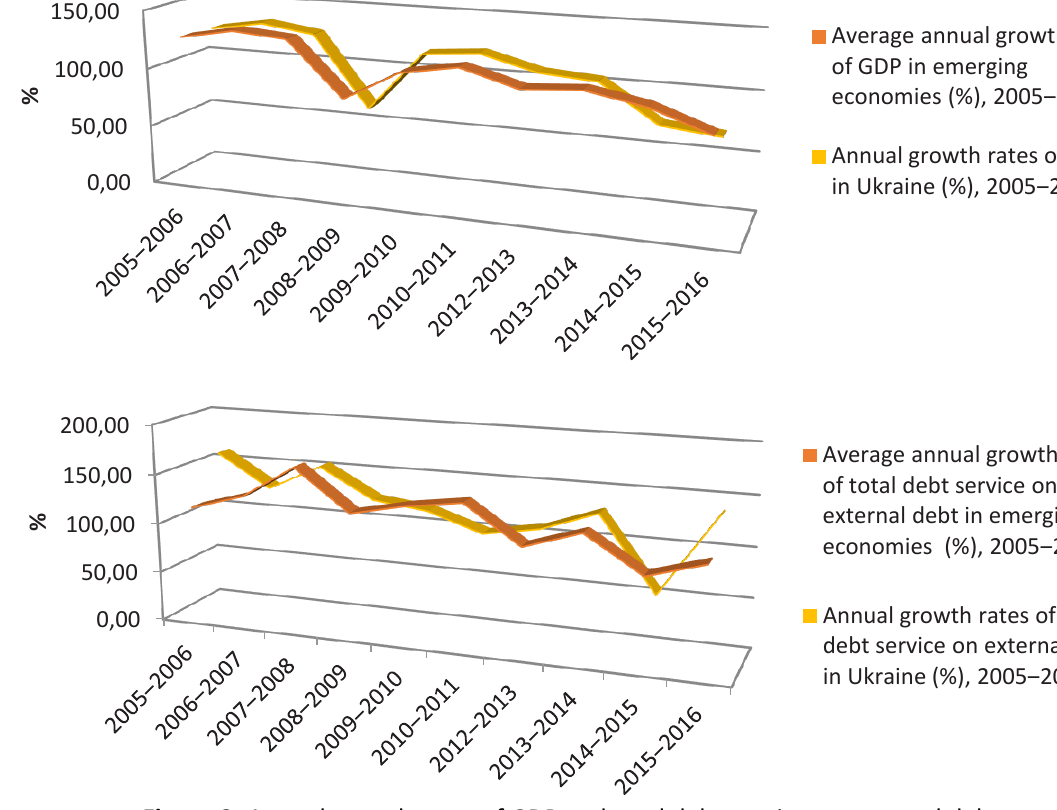
Figure 2. Annual growth rates of GDP and total debt service on external debt in emerging economies,